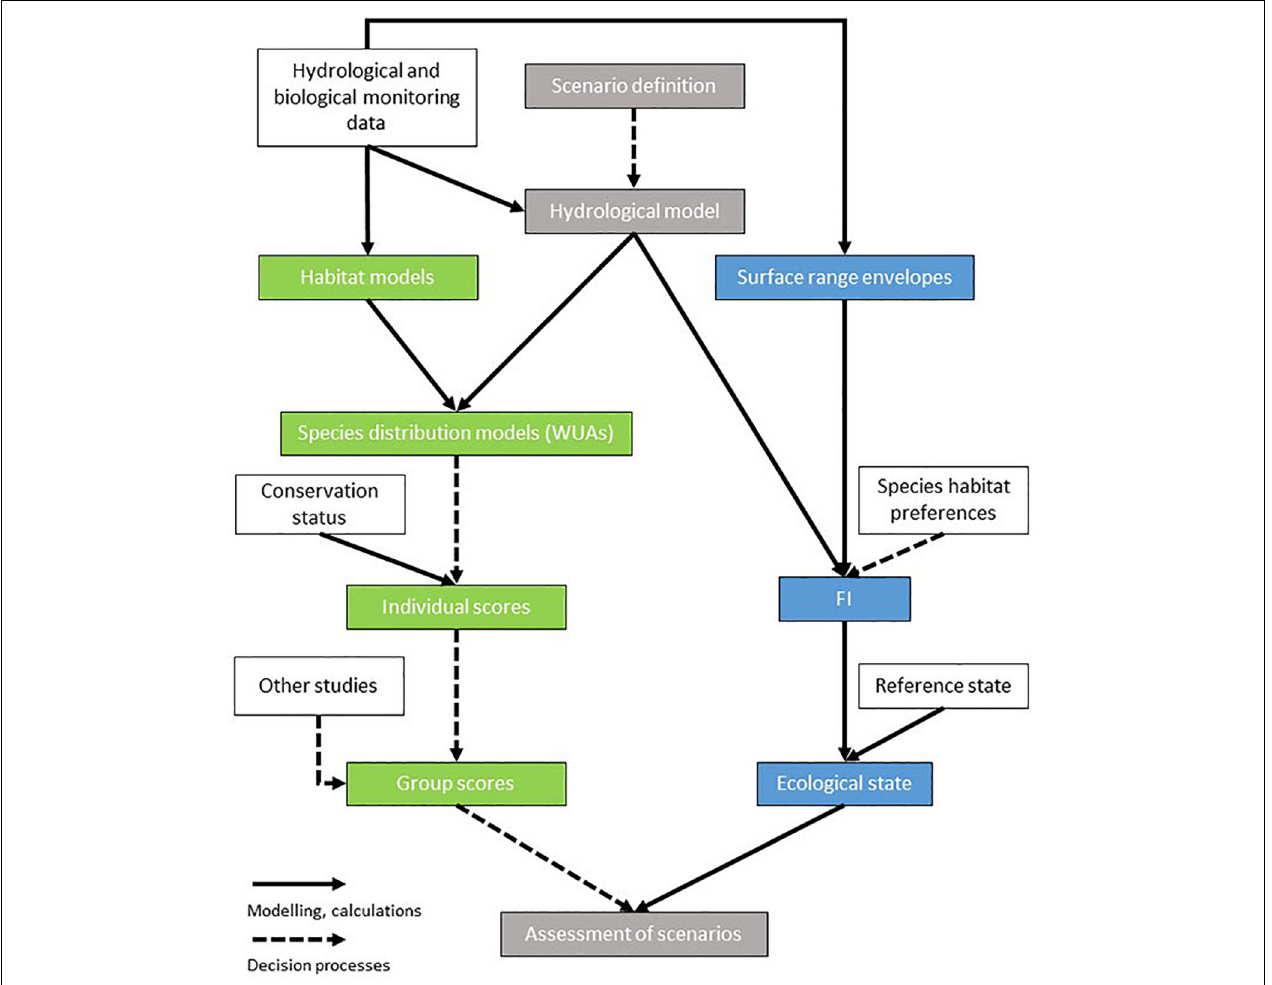
FIGURE 2 | Work flow diagram for the assessment of the restoration scenarios according to the Habitats and Birds Directive and nature protection laws (left, green boxes) and the Floodplain Index (relating to the Water Framework Directive; right, blue boxes). Full lines indicate modeling and calculations, dotted lines decision processes. White boxes indicate data necessary for the modeling and decision